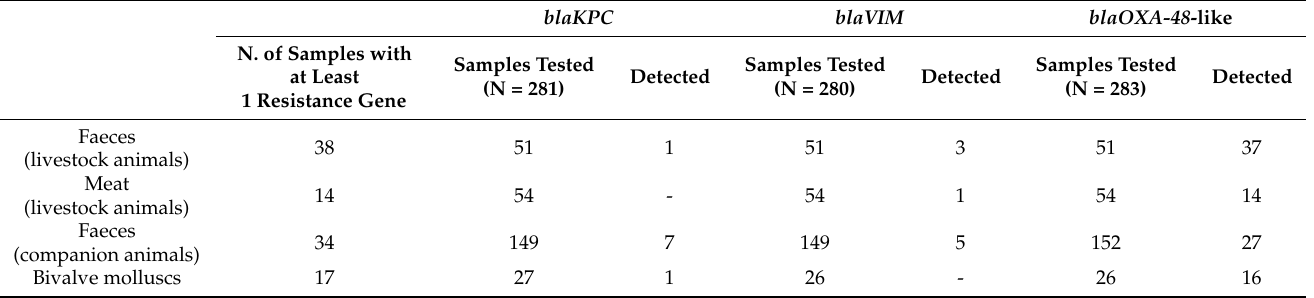
Table 4. Antibiotic resistance genes detected by ddPCR by sample type and by tested resistance genes. blaKPC blaVIM blaOXA-48